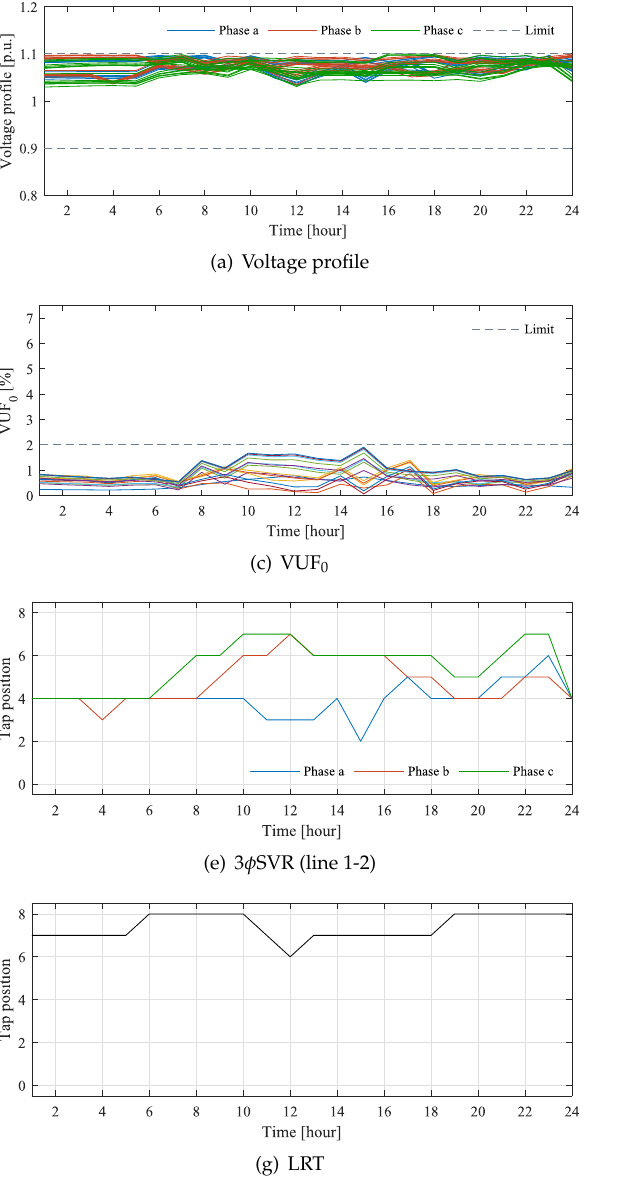
Figure 8. Simulation result of Case 4: minimize losses with voltage unbalance penalty; the different colors in ( b – d ) refer to different buses. Similar to Case 2, all unbalance metrics are less than 2% for all-day.